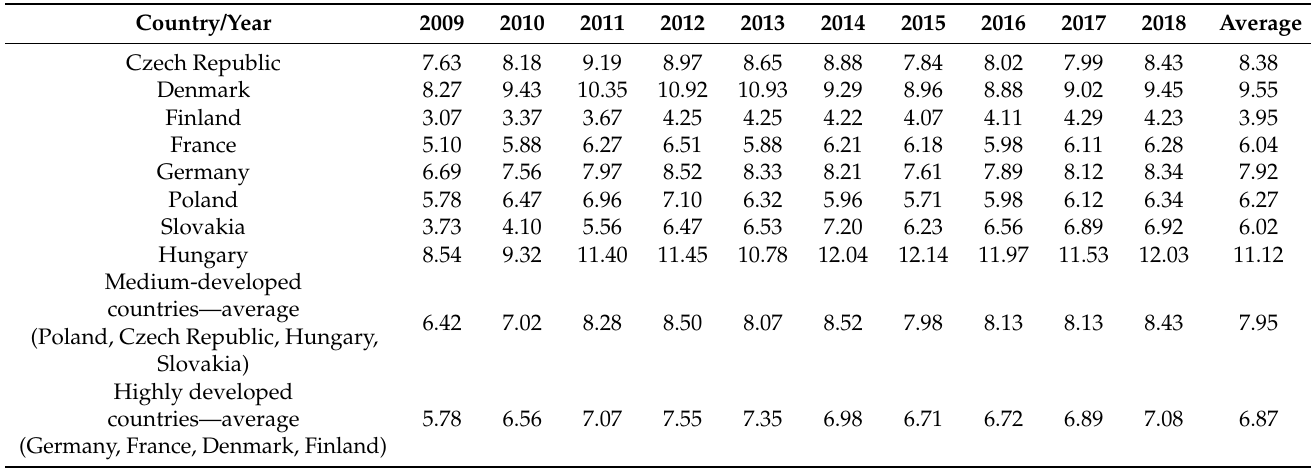
Table 9. Total income from agricultural production per capital employed in agriculture of the surveyed EU countries